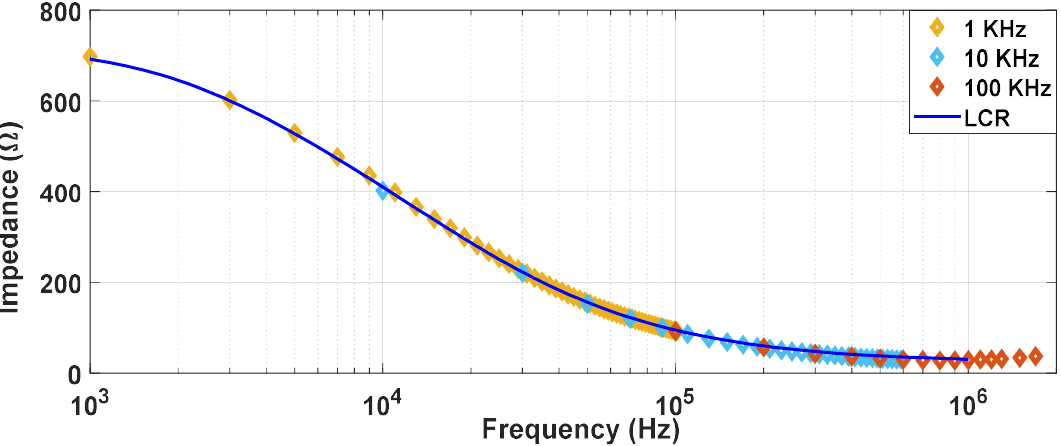
Figure 4. Module of the impedance measurement: comparison of the measurements obtained by processing the data obtained from the proposed generator at different frequencies and by a precision impedance analyser (LCR).